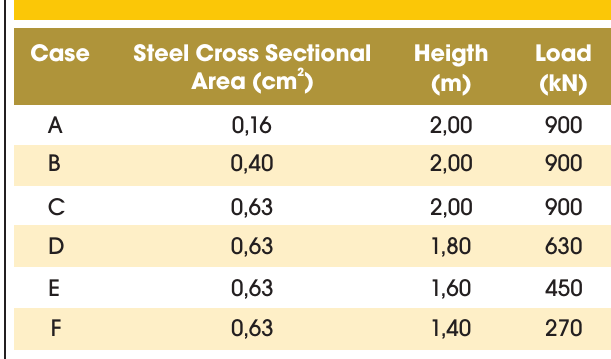
Table 1 – Characterization of the studied